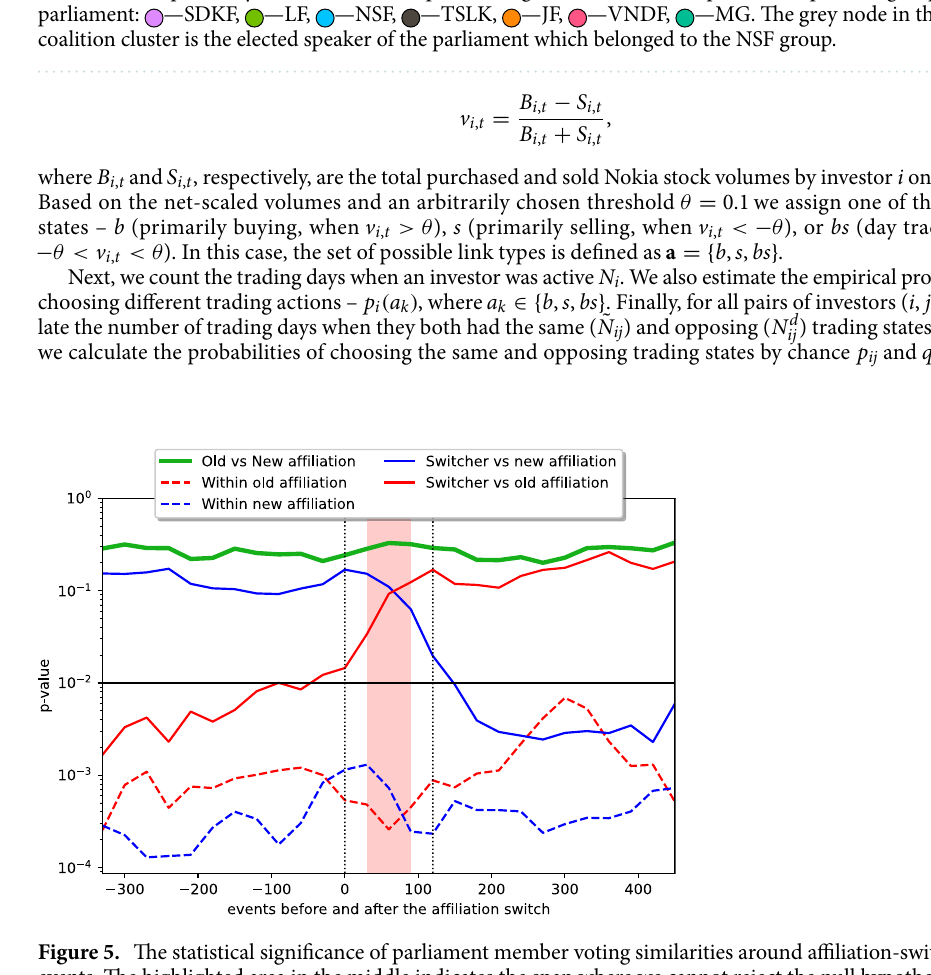
Figure 4. A validated political network inferred from a bipartite network where parliament members vote on different questions. The cluster on the right is composed of members that formed the ruling coalition, while the members on the right were in opposition. The layout is based on the positive (green) links only. The size of the nodes is positively associated to their positive degrees. Node colors represent the political groups in the